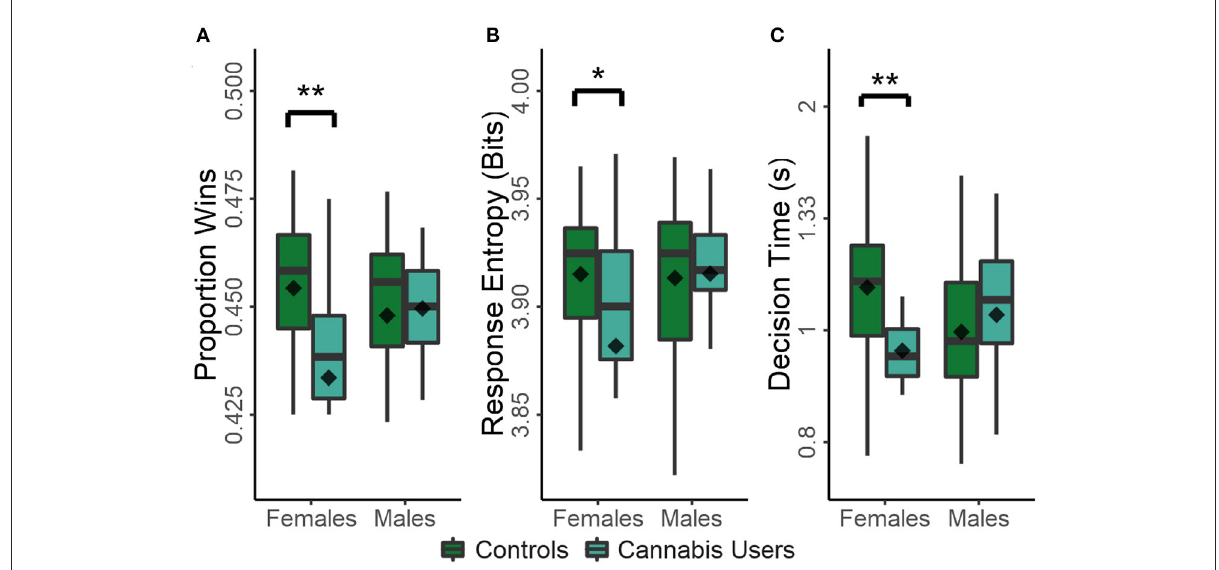
FIGURE2 Effect of recreational drug use on measures of task performance in males and females: proportion of wins (A) ; response entropy (B) ; and decision times (C) . Plots show the conventional descriptive statistics: mean (diamond), median (horizontal line in the box), 25th/75th percentiles (box edges), and outliers (dots). ∗ p < 0.05, ∗∗ p <